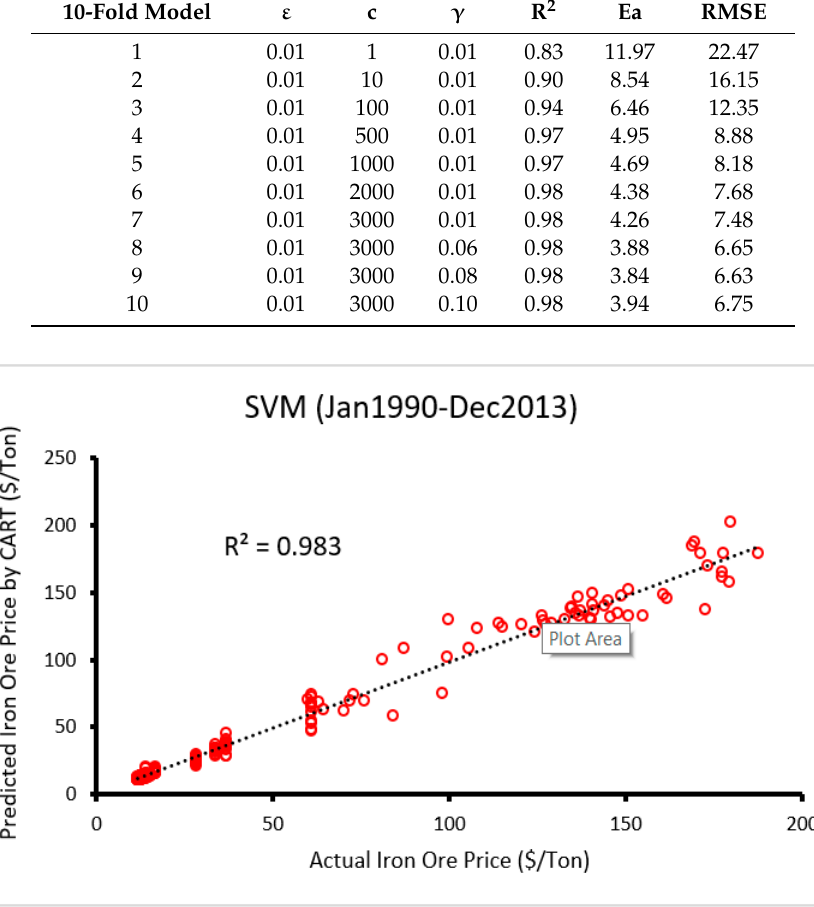
Figure 7. Scatter plot of the predicted vs. actual iron ore price developing support vector regression (SVR) model.